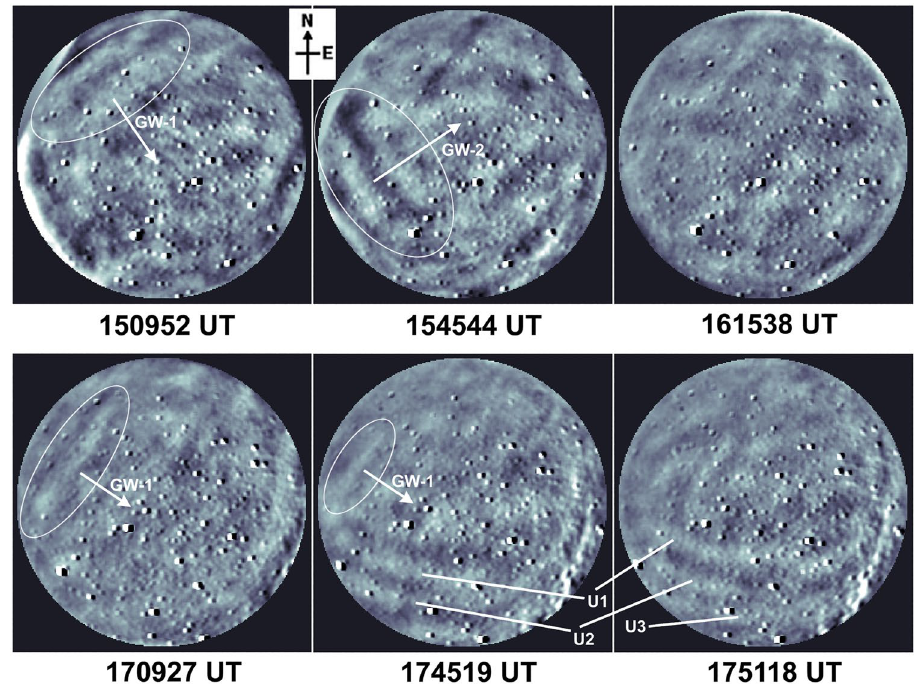
Figure 3. Sample TD OH broadband nightglow images during 15:00–18:00 UT featuring small-scale GWs seen over Prayagraj. GWs propagating towards the south-east and north-east are represented by GW-1 and GW-2, respectively. Some detected fronts of GWs that possibly modified the ionization rate and created suitable conditions for sprite initiation are marked by U1, U2, and U3.